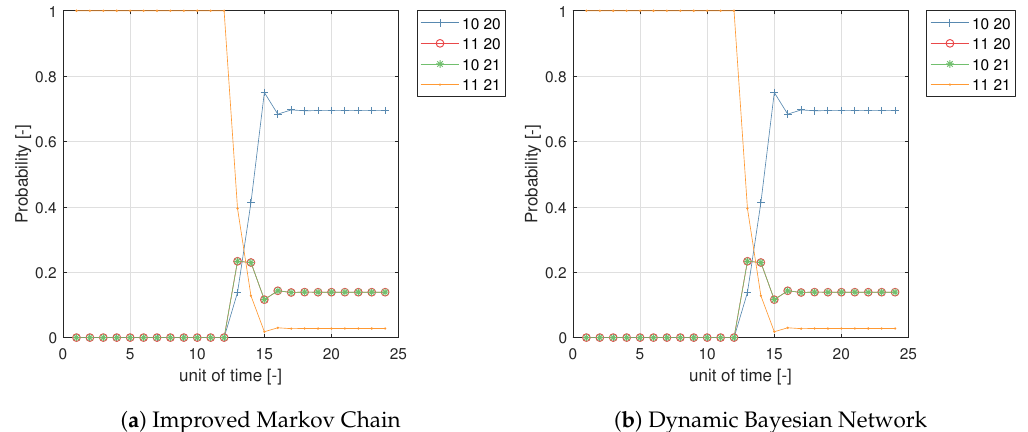
( b ) Dynamic Bayesian Network Figure 7. Network State Probability: Two critical lines with the wind spatial profile ‘B’.